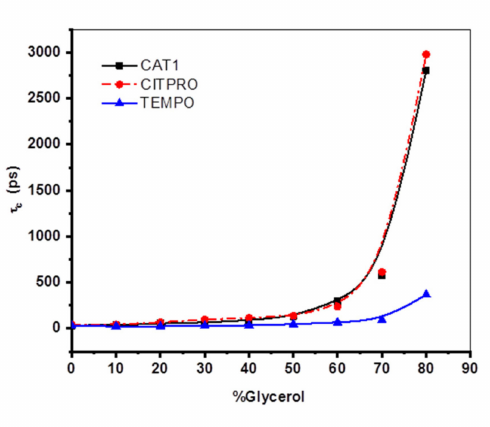
Figure 5. The e ff ect of increasing viscosity on the rotational correlation time of spin probes. The two spin probes CAT1 and CITPRO are strongly a ff ected at viscosities above 60 percent of glycerol. The lines are second order polynominal fits to the data points and are given only as a guide to the